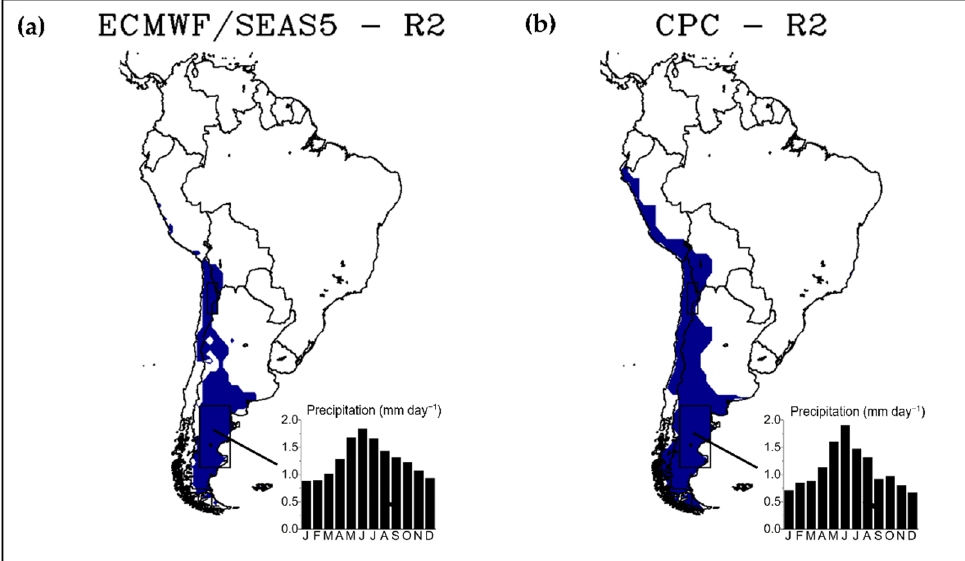
Figure 7. Similar to Figure 6, except for Region 2